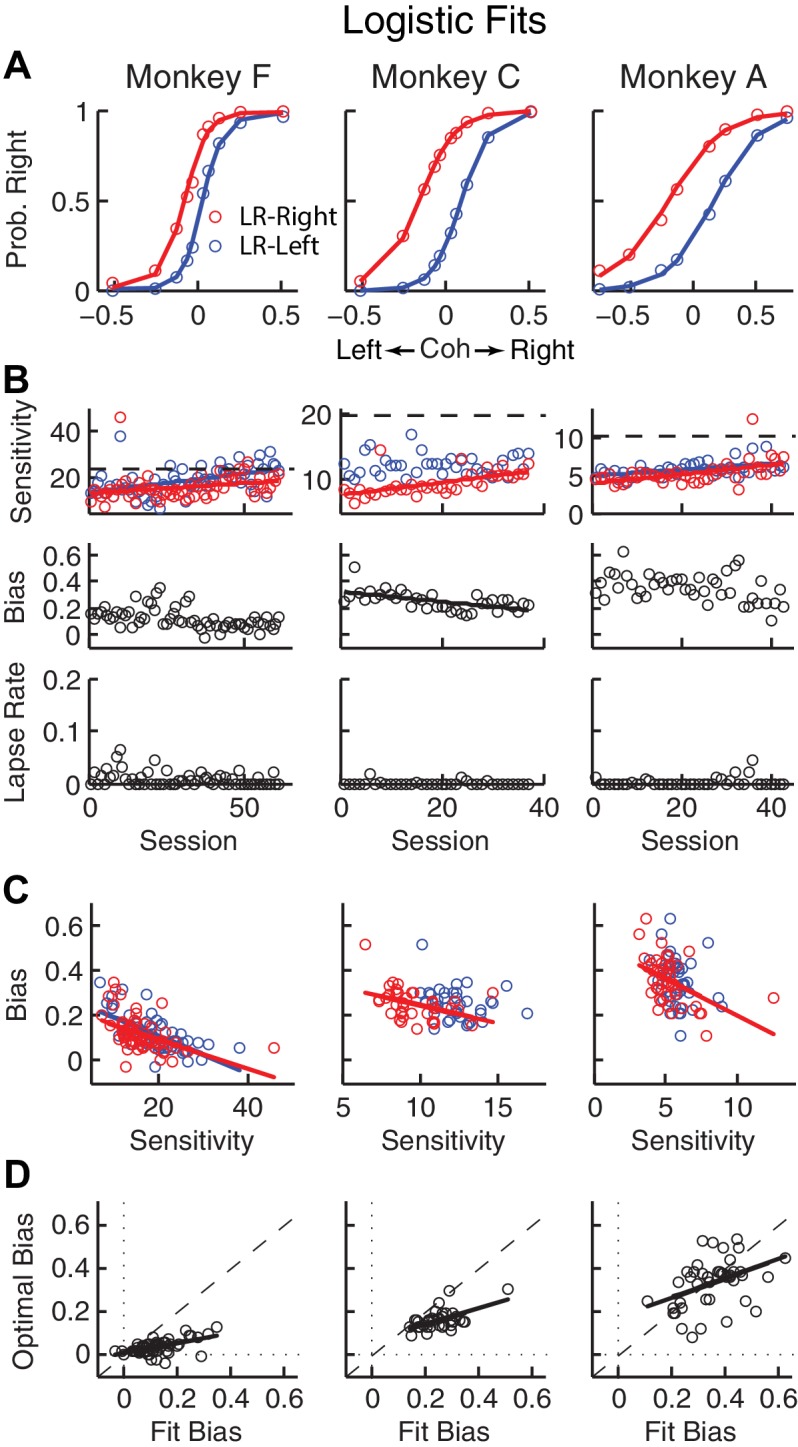
Relationships between sensitivity and bias from logistic fits to choice data.(A) For each monkey, the probability of making a rightward choice is plotted as a function of signed coherence (–/+indicate left/right motion) from all sessions, separately for the two reward contexts, as indicated. Lines are logistic fits. (B) Top row: Motion sensitivity (steepness of the logistic function) in each context as a function of session index (colors as in A). Solid lines indicate significant positive partial Spearman correlation after accounting for changes in reward ratio across sessions (p<0.05). Black dashed lines indicate each monkey’s motion sensitivity for the task with equal rewards before training on this asymmetric reward task. Middle row: ΔBias (horizontal shift between the two psychometric functions for the two reward contexts at chance level) as a function of session index. Solid line indicates significant negative partial Spearman correlation after accounting for changes in reward ratio across sessions (p<0.05). Bottom row: Lapse rate as a function of session index (median = 0 for all three monkeys). (C) ΔBias as a function of motion sensitivity for each reward context (colors as in A). Solid line indicates a significant negative partial Spearman correlation after accounting for changes in reward ratio across sessions (p<0.05). (D) Optimal versus fitted Δbias. Optimal Δbias was computed as the difference in the horizontal shift in the psychometric functions in each reward context that would have resulted in the maximum reward per trial, given each monkey’s fitted motion sensitivity and experienced values of reward ratio and coherences from each session (see Figure 2—figure supplement 1). Solid lines indicate significant positive Spearman correlations (p<0.01). Partial Spearman correlation after accounting for changes in reward ratio across sessions are also significant for moneys F and C (p<0.05).10.7554/eLife.36018.006Figure 2—source data 1.Task parameters and the monkeys’ performance for each trial and each session.The same data are also used in Figure 2—figure supplement 1, Figure 3, Figure 3—figure supplement 2, Figure 4 and Figure 4—figure supplement 110.7554/eLife.36018.007Figure 2—source data 2.Source data for Figure 2—figure supplement 1.Log-likelihood of the logistic regressions with and without sequential choice bias terms.